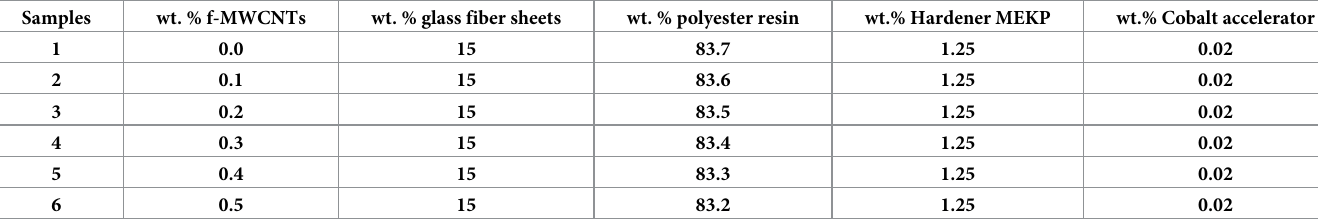
Table 1. Sample designation and weight percentages of glass fiber, polyester, and f-MWCNTs in the hybrid samples. Samples wt. %